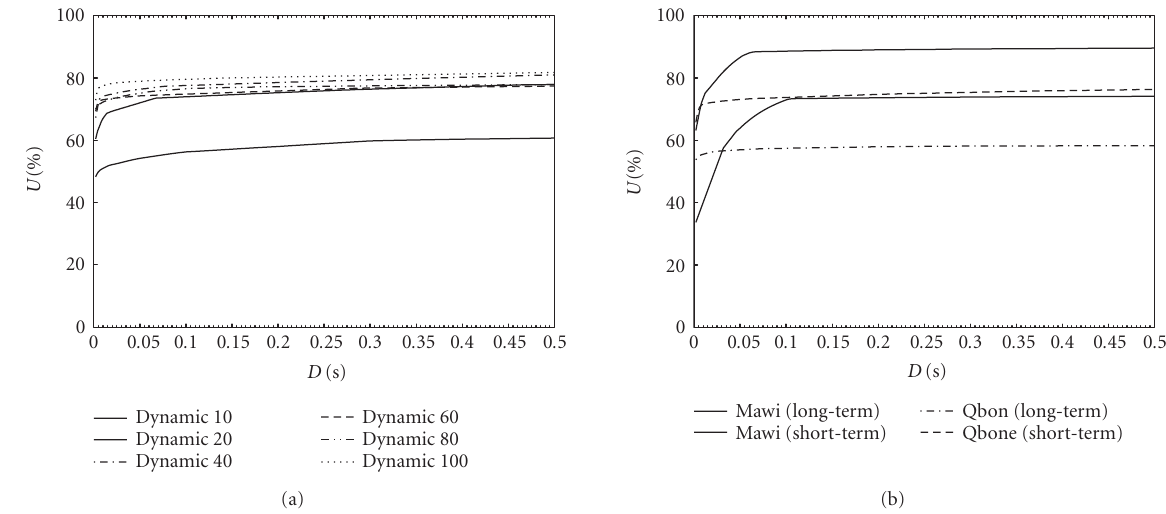
Figure 8: Bandwidth utilisation for (a) dynamic aggregates and (b) short- and long-term traces.